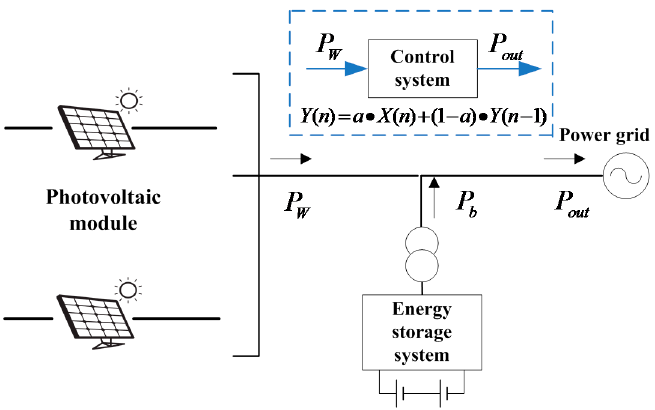
Figure 6. Schematic diagram of the first-order low-pass filter control algorithm for energy storage systems.